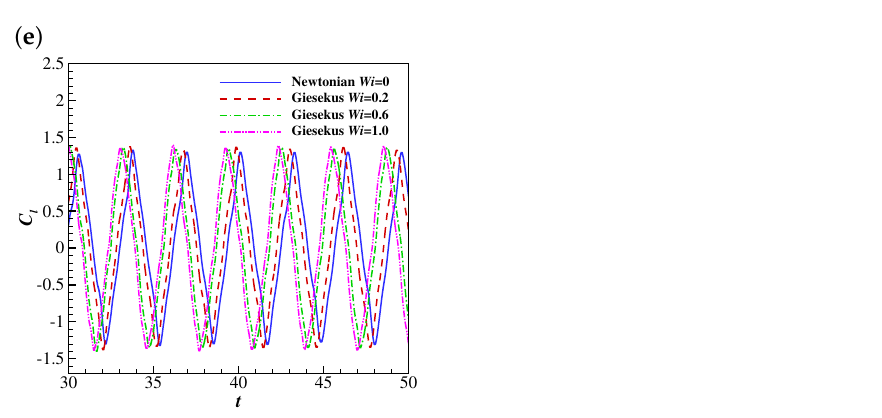
Figure 12. The time histories of the lift coefficient on the filament in Newtonian and Giesekus uniform flows at Re = ( a ) 10, ( b ) 25, ( c ) 50, ( d ) 100 and ( e ) 200.